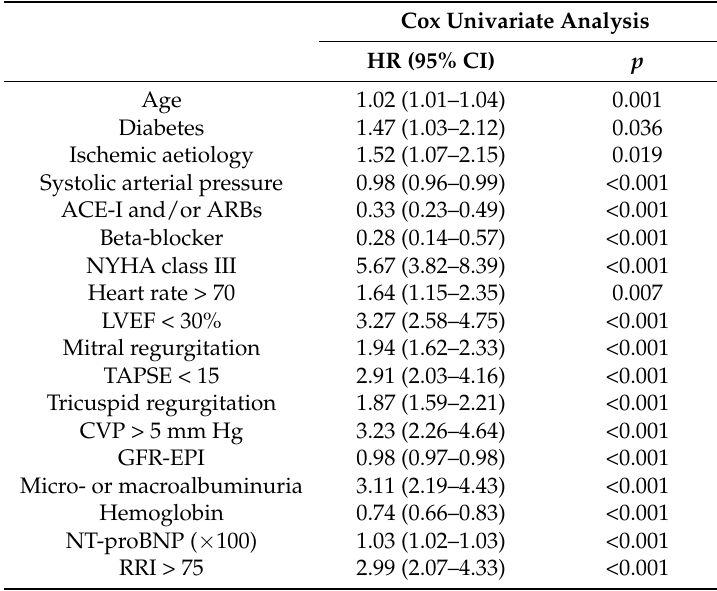
Table 2. Univariate analysis for primary end-point. For abbreviations see Table 1.